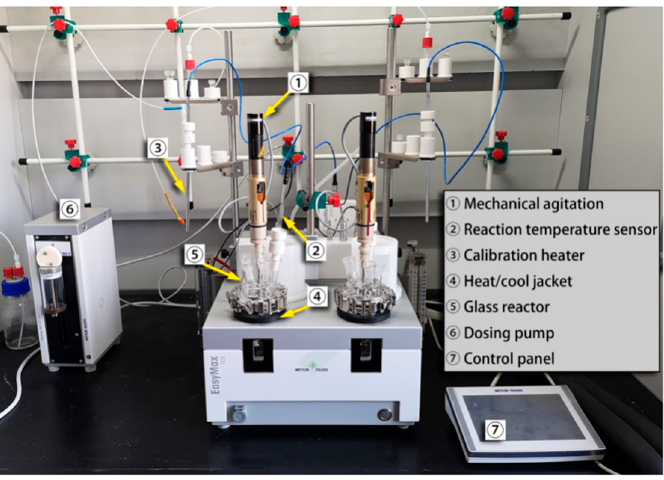
Figure 8. The instruments used in the temperature control experiments (EasyMax 102).